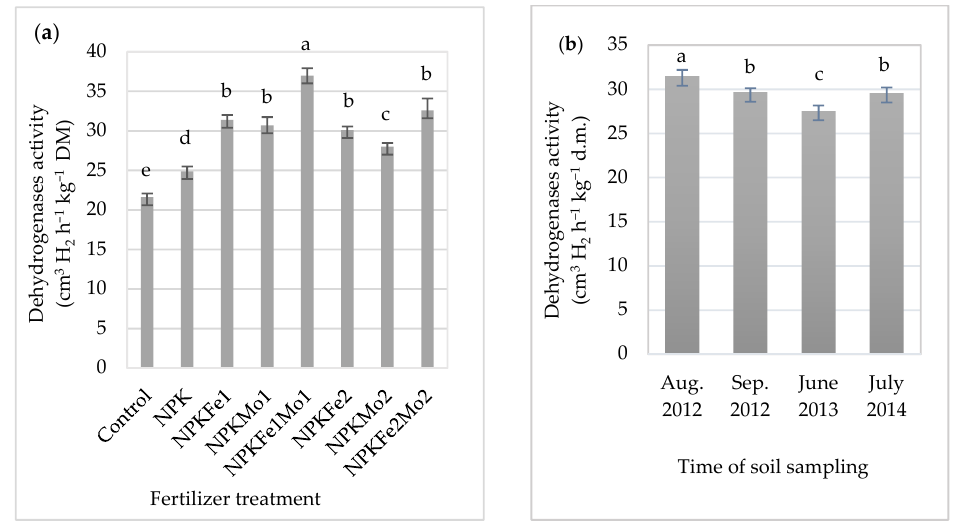
Figure 3. The effects of mineral fertilizer treatment ( a ) and time of soil sampling ( b ) on dehydrogenases activity. Each bar represents the mean ± SE. The same letters mark no significantly different values ( p ≤ 0.05).